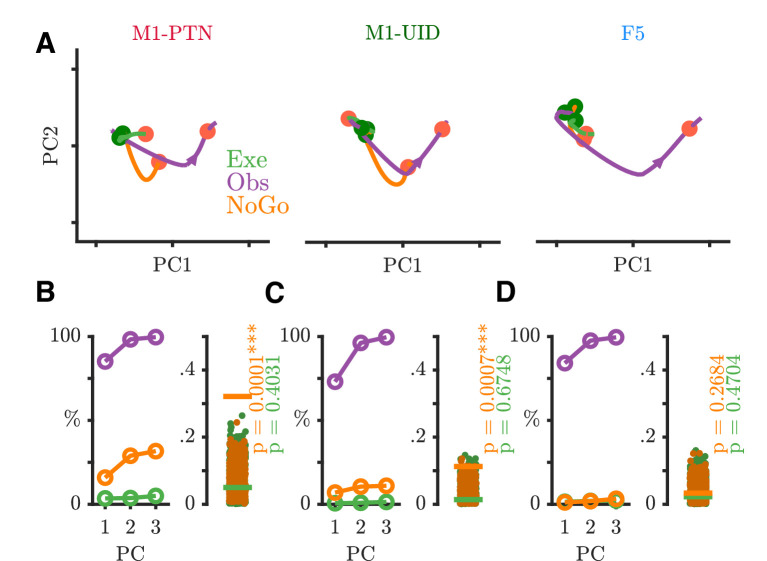
NoGo activity within an observation subspace.(A) Traces showing the evolution of M1-PTNs, M1-UIDs and F5 population activity during PG execution (green), observation (purple) and NoGo (orange) conditions within the first 2 dimensions of an observation subspace spanning the 100–400 ms after the Go cue. Each trajectory shows the −100 to +400 ms period around the Go/NoGo cue (green/red circles). Average HPR time (across execution and observation) is also indicated on each trajectory by the orange filled circles. The purple arrow on observation trajectories indicates the direction of time. (B) M1-PTNs Left Panel: Cumulative variance captured within the first three principal axes for execution, observation, and NoGo. Right Panel: Alignment indices of execution and NoGo activity in the observation subspace shown as coloured lines (Execution - green, NoGo - orange). Observation alignment index is equal to one by definition (not shown). Scattered points show alignment values from null distributions for execution and NoGo separately, and p-values denote proportion of alignment values in null distribution greater than alignment in data. (C) Same as B., but for M1-UIDs. (D) Same as B, but for F5.